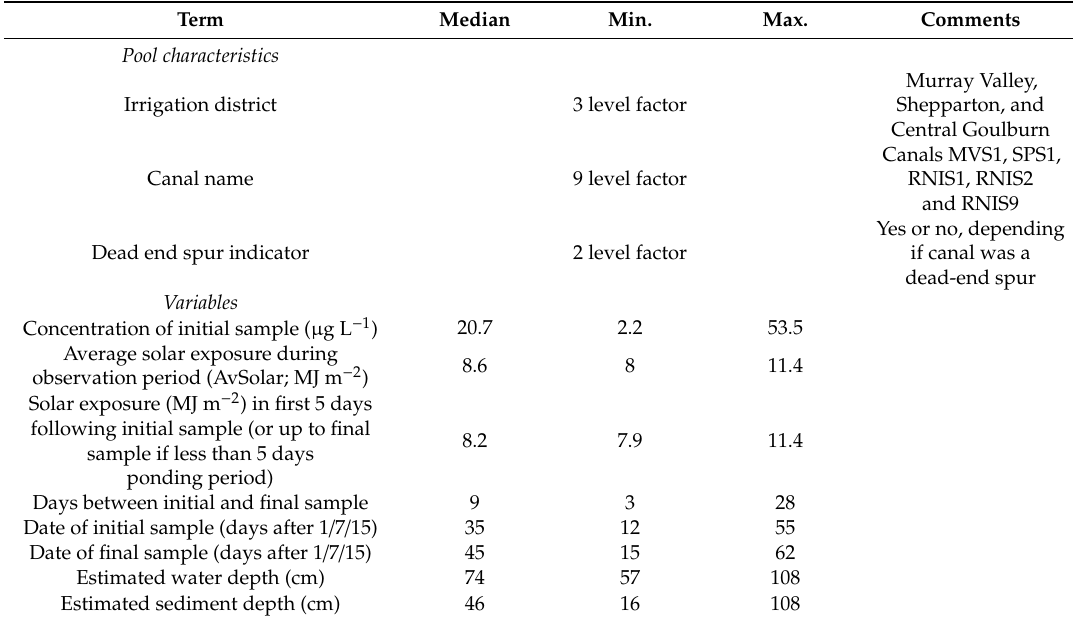
Table 3. Terms assessed for inclusion in the model of imazapyr dissipation during ponding (Model 2). Term Median Min.